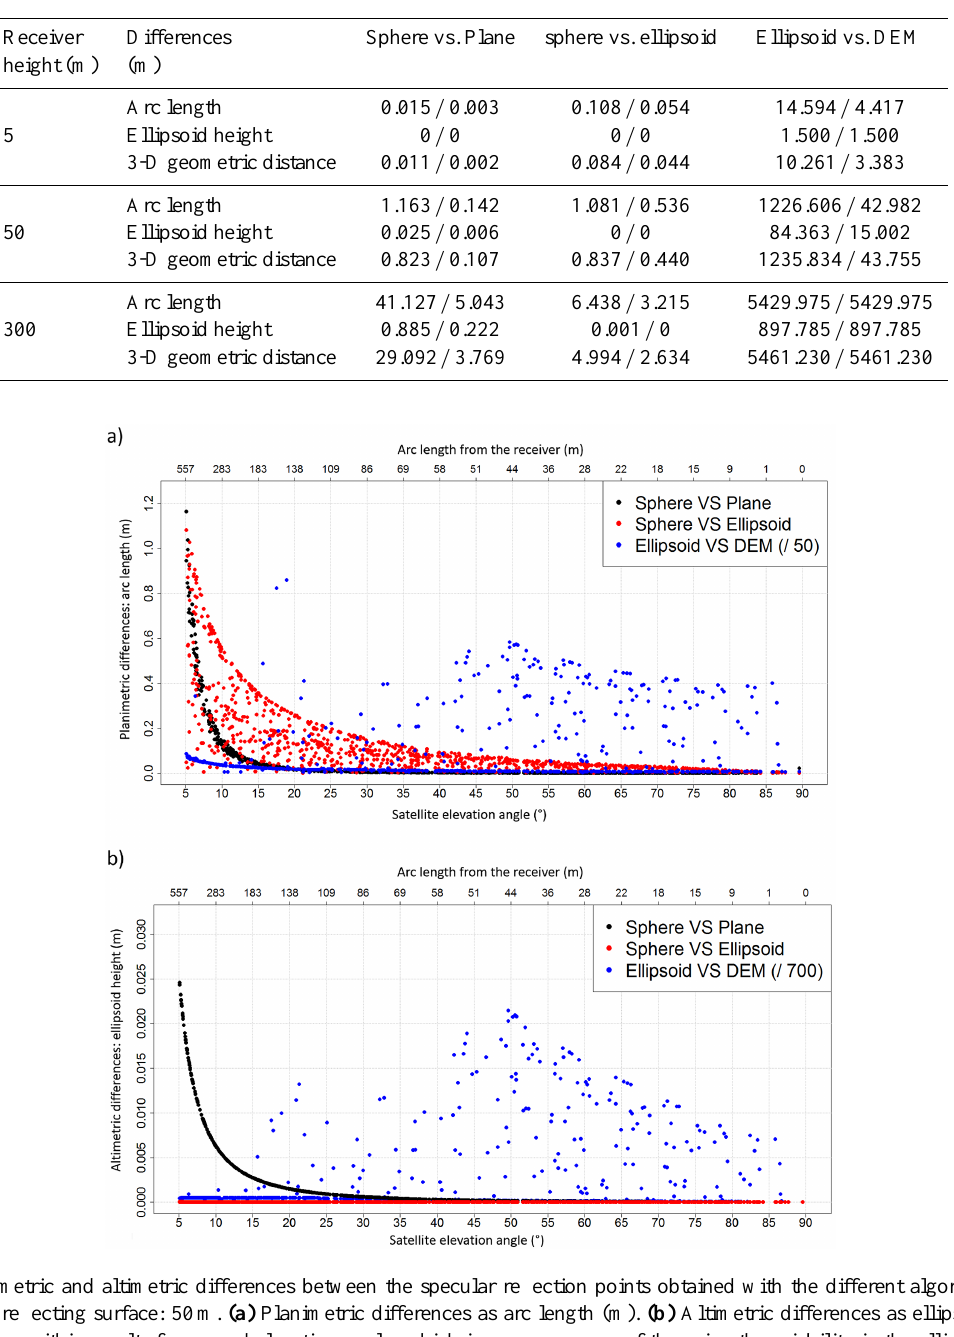
Table 2. Maximum differences between the positions of the specular reflection points obtained with the different algorithms and for different receiver heights above the reflecting surface. For each cell of this table, the first number is the result obtained with the minimum satellite elevation angle set to 5 ◦ , and the second number is the result obtained with the minimum satellite elevation angle set to 10 ◦ .